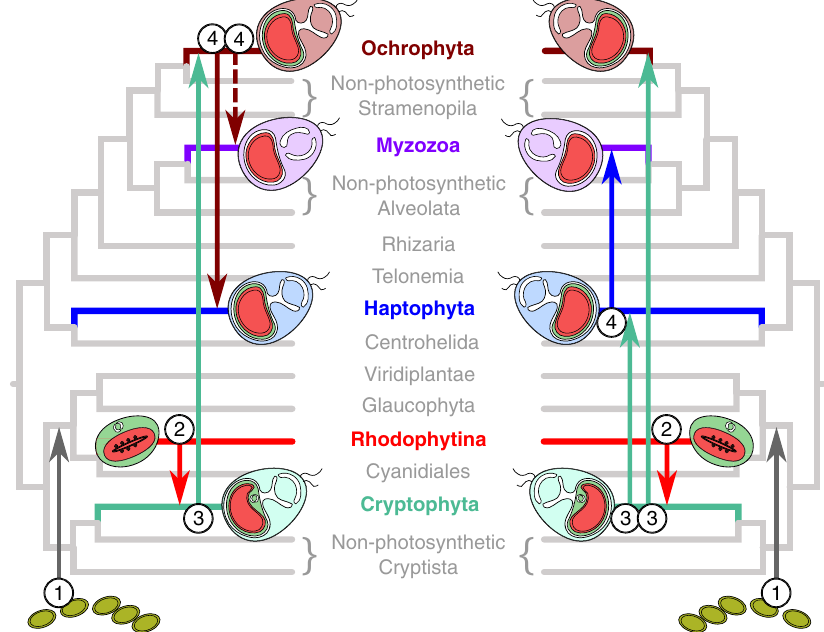
Fig. 1 Serial plastid endosymbioses models as proposed by Stiller et al. 18 (left) and Body ł et al. 46 (right). The tree topology shown here is based on the results obtained in our study. Further models have been suggested but are not compatible with this topology 15,117,118 . Numbers denote the level of endosymbiosis events. Note, Myzozoa were not included by Stiller et al. 18 and the dashed line indicates engulfment of an ochrophyte by the common ancestor of Myzozoa as suggested by Sevcikova et al. 19